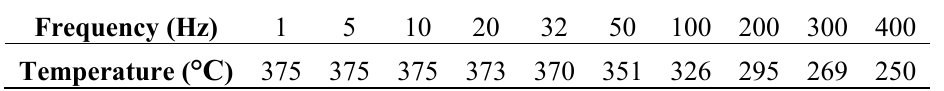
Table 2. Temperature variation of the center shaft versus frequency of applied voltage.